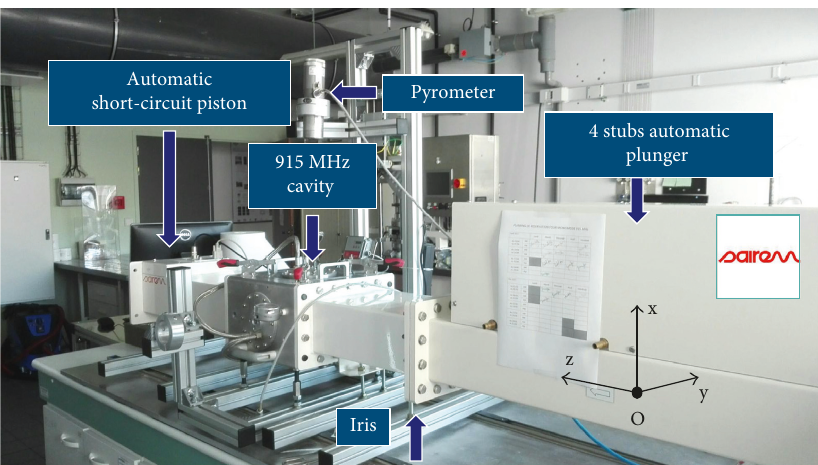
Figure 2: Photograph showing the overall 915MHz microwave process. The short circuit motorization and the 4 stubs automatic plunger are connected to a personal computer and can be monitored by it.